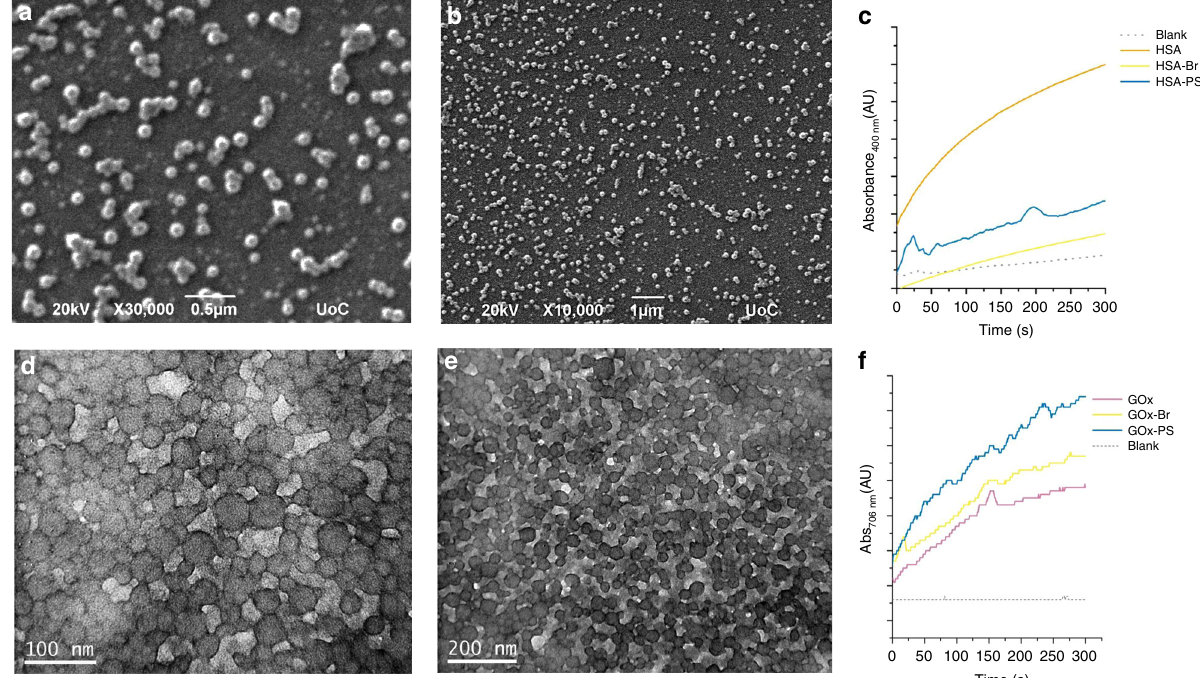
Fig. 6 Morphological characterization and activity of protein-polymer bioconjugates. a , b SEM micrographs of HSA-PS uniform spherical assemblies synthesized using molar feed ratio [M n ]/[I o ] = 2000/1; c Esterase-like initial activity of HSA and HSA-bioconjugates; d , e TEM micrographs of GOx-PS spherical assemblies synthesized using molar feed ratio [M n ]/[I o ] = 2000/1 (samples stained with uranyl acetate); f Initial activity of GOx and GOx-